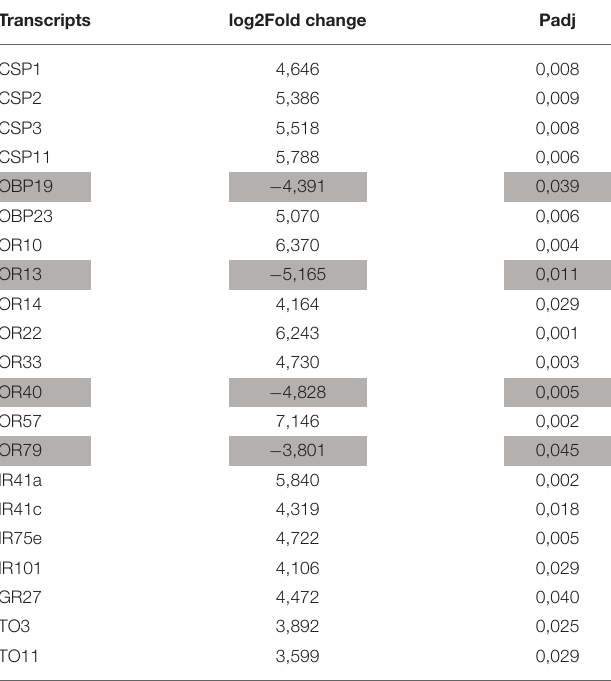
TABLE 4 | Transcripts of interest detected as differentially expressed (DE) with DESeq2 in sylvatic vs. reared samples.